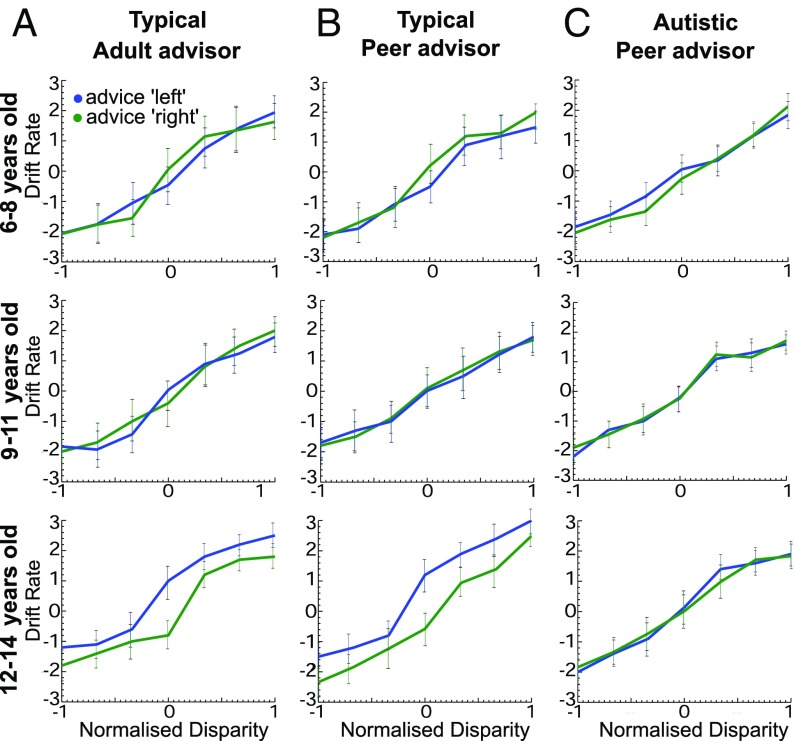
Drift rates under social influence for neurotypical and autistic children. (A) Drift rates were estimated for each stimulus disparity and social influence direction using a model in which drift rate and starting point were allowed to vary with social influence direction and with stimulus disparity. Median drift rates are plotted against normalized cylinder disparity for neurotypical children judging cylinder rotation under social influence from a gender-matched adult. As expected, median drift rates vary with the level of, and in the direction of, stimulus disparity at all ages, but only the 12- to 14-y-olds display a distinct deviation of drift rates in the direction of social influence. A positive drift rate indicates drift in the leftward response direction, and vice versa. (B) Median drift rates are shown for neurotypical children who made perceptual decisions under social influence from an age- and gender-matched peer. Again, only the 12- to 14-y-olds show a distinct deviation of drift rates in the direction of social influence. (C) Median drift rates for autistic children who were advised by an age- and gender-matched peer showed no systematic bias with social influence for any age group. Autistic children matched the neurotypical group in B in IQ. All conventions as in A. Error bars show 95% confidence limits.